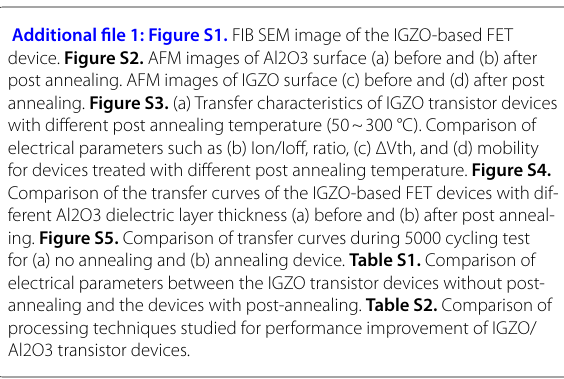
sweep cycles. The raw data of the linear transfer curves for each device are also displayed in Additional file 1: Figure S5. The on and off data for the post-annealed device remained stable without serious current fluc- tuation when compared to the non-annealed transistor.